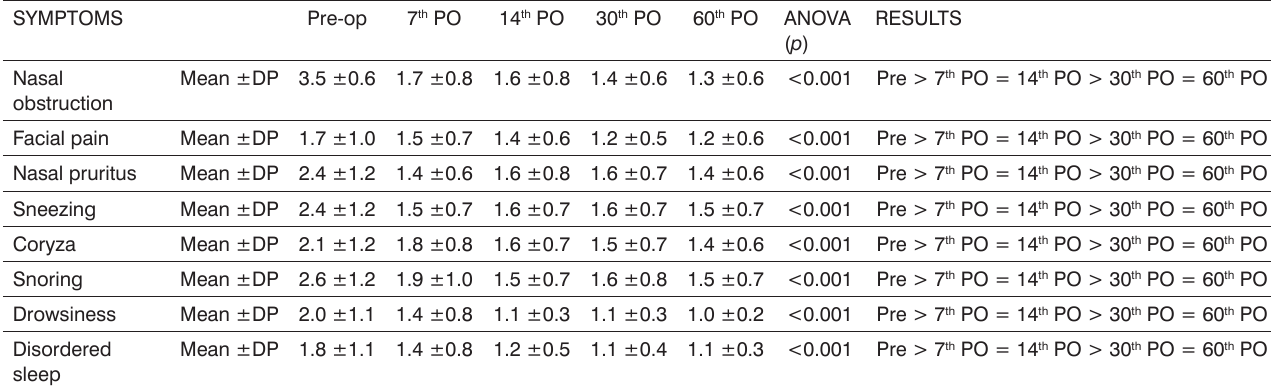
Chart 1. Mean nasal symptom scores (nasal obstruction, facial pain, nasal pruritus, sneezing bouts/sneezing, coryza, snoring, daytime drowsiness, and sleep disorders) in the preoperative (Pre) and postoperative (PO) periods.